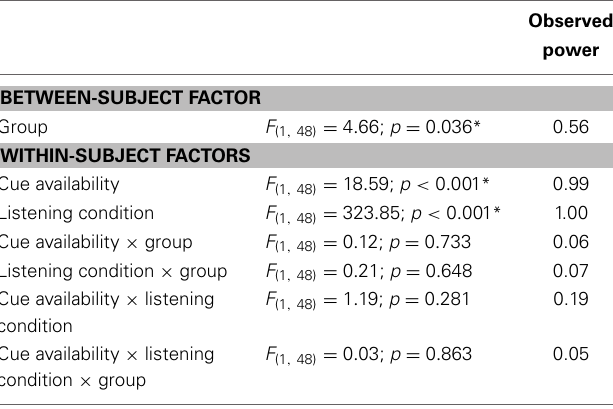
piano A3 masker [ t (48) = − 5 . 10, p < 0 . 001], the organ